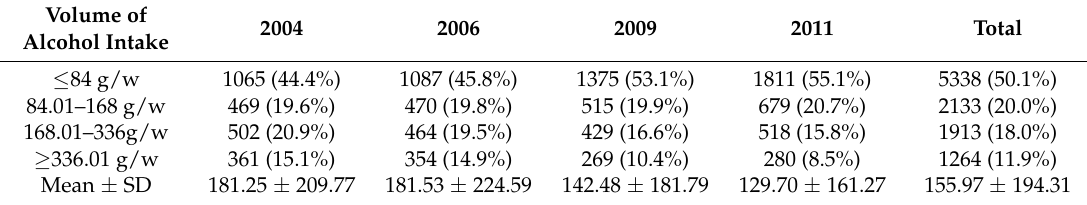
Table 2. Distribution of 10,684 males with different alcohol intakes during the survey year ( n , %), CHNS.